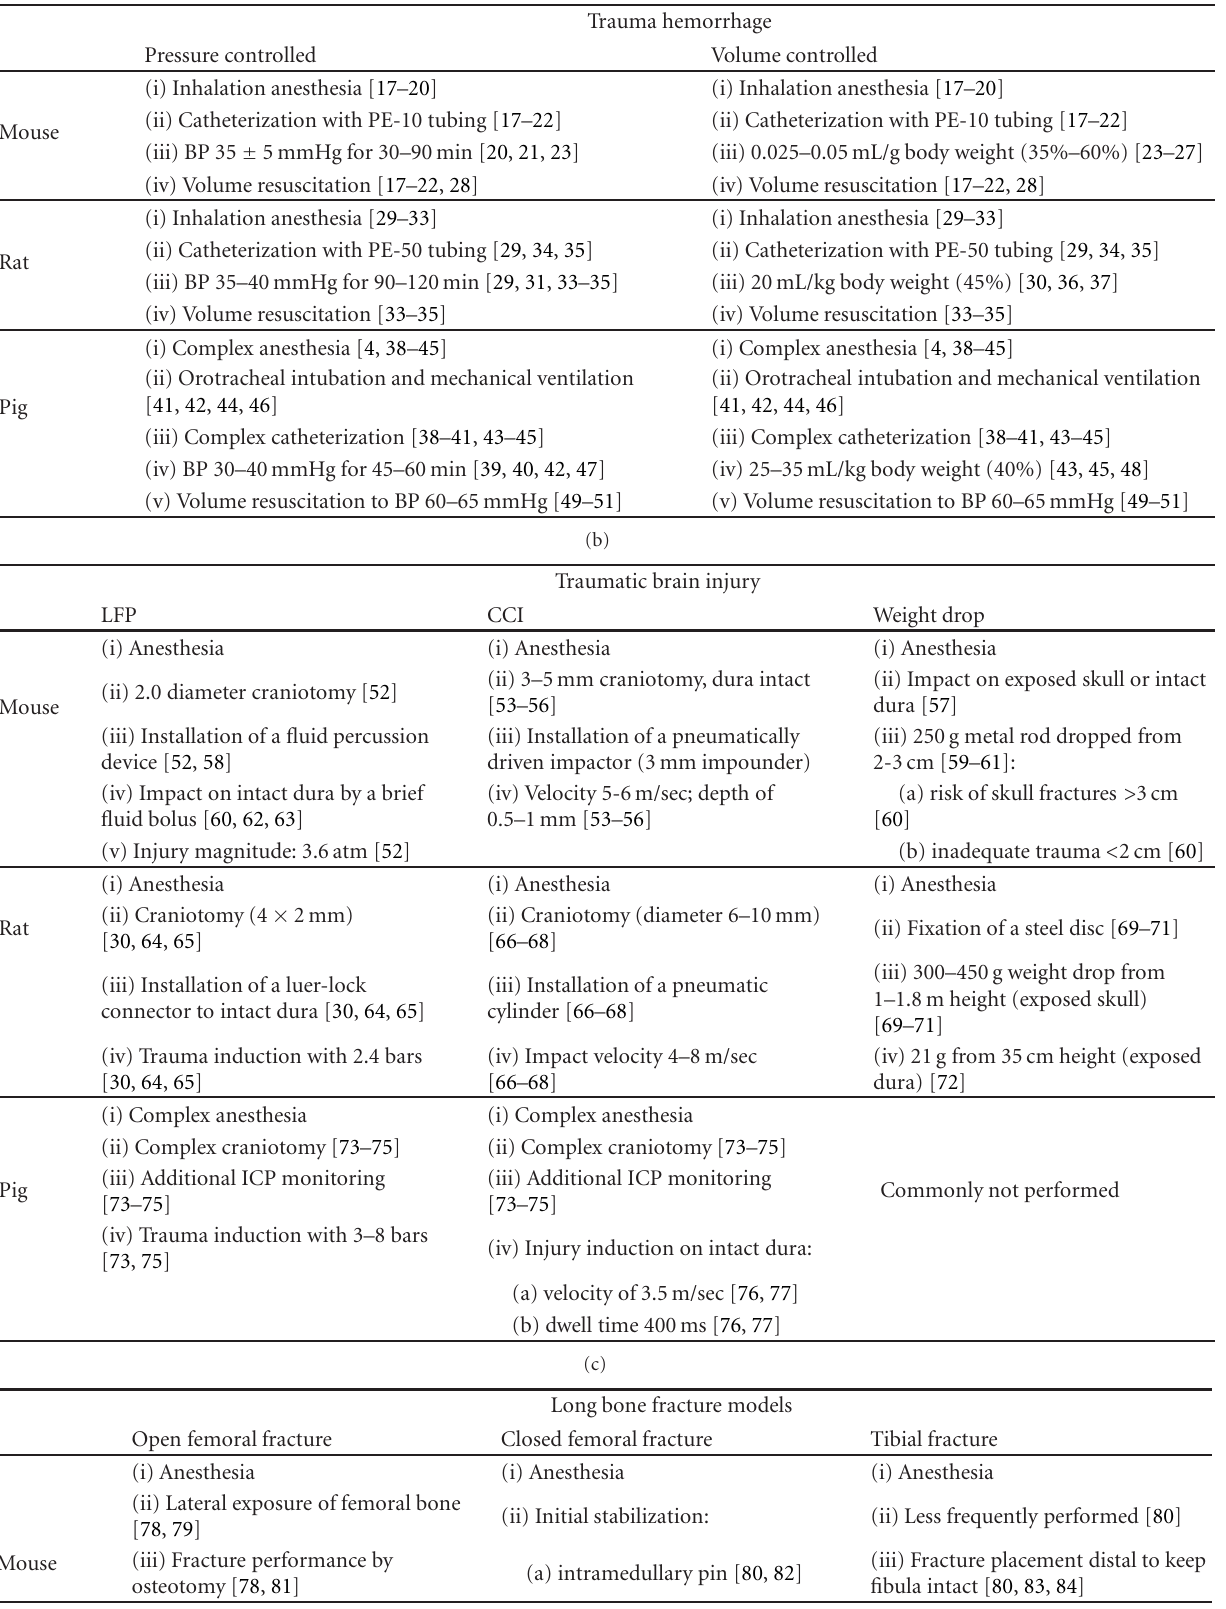
Table 1: Available animal models simulating relevant traumatic